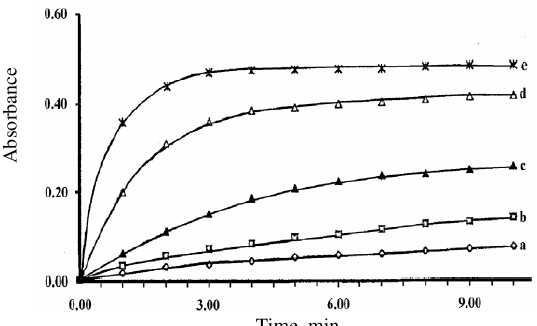
Figure 4. Effect of H + concentrations (a-e, 1.6 x 10 -4 M, 1.0 x 10 -4 M, 6.0 x 10 -5 M, 3.2 x 10 -5 M and 1.8 x 10 -5 M, respectively) on the absorbance of the reaction at λ